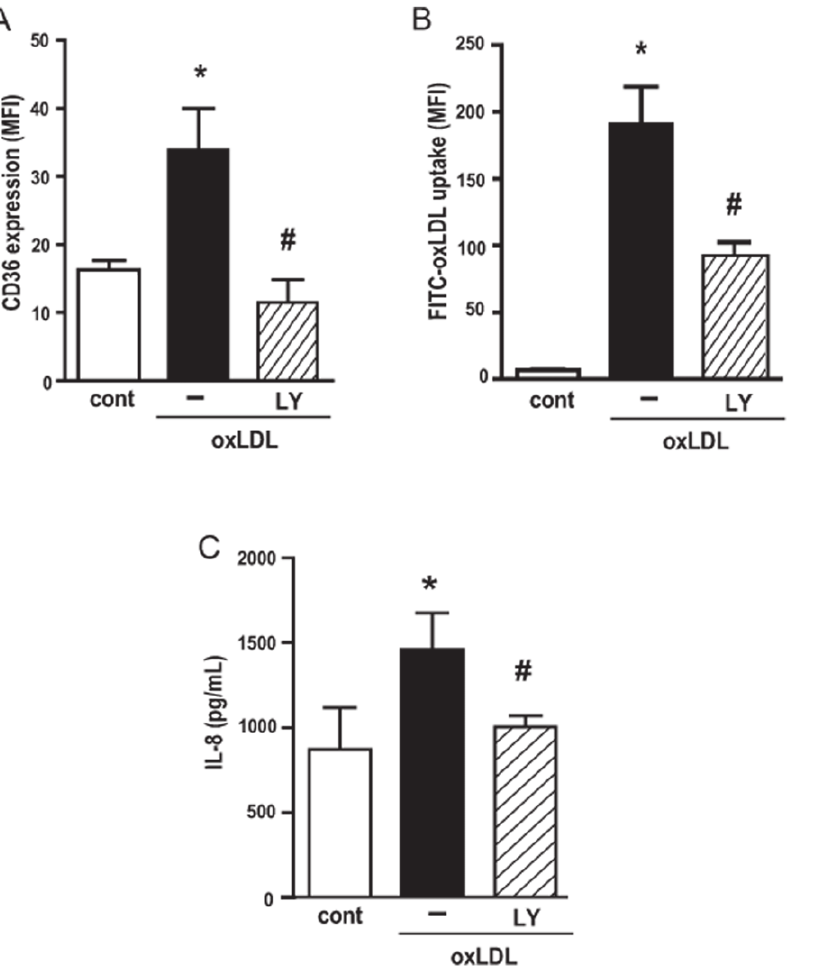
Figure 3. PI3K/Akt pathway is required for oxLDL induced upregulation of CD36 expression (A) oxLDL uptake (B) and IL-8 production (C). Adherent human monocytes/macrophages were treated with LY294002 (10 m M, 30 min), and then stimulated with oxLDL (30 m g/ mL) for 24 h. The expression of CD36 was measured by FACS and IL-8 production by ELISA. For the uptake evaluation, stimulated cells were washed and incubated with FITC-oxLDL for 1 h and uptake was measured by FACS. Data are presented as mean 6 SEM of the mean fluorescence Intensity of five donors. * p , 0.05 comparing oxLDL stimulated with non-stimulated cells (cont). # p , 0.05 comparing cells treated with LY294002 with non- treated